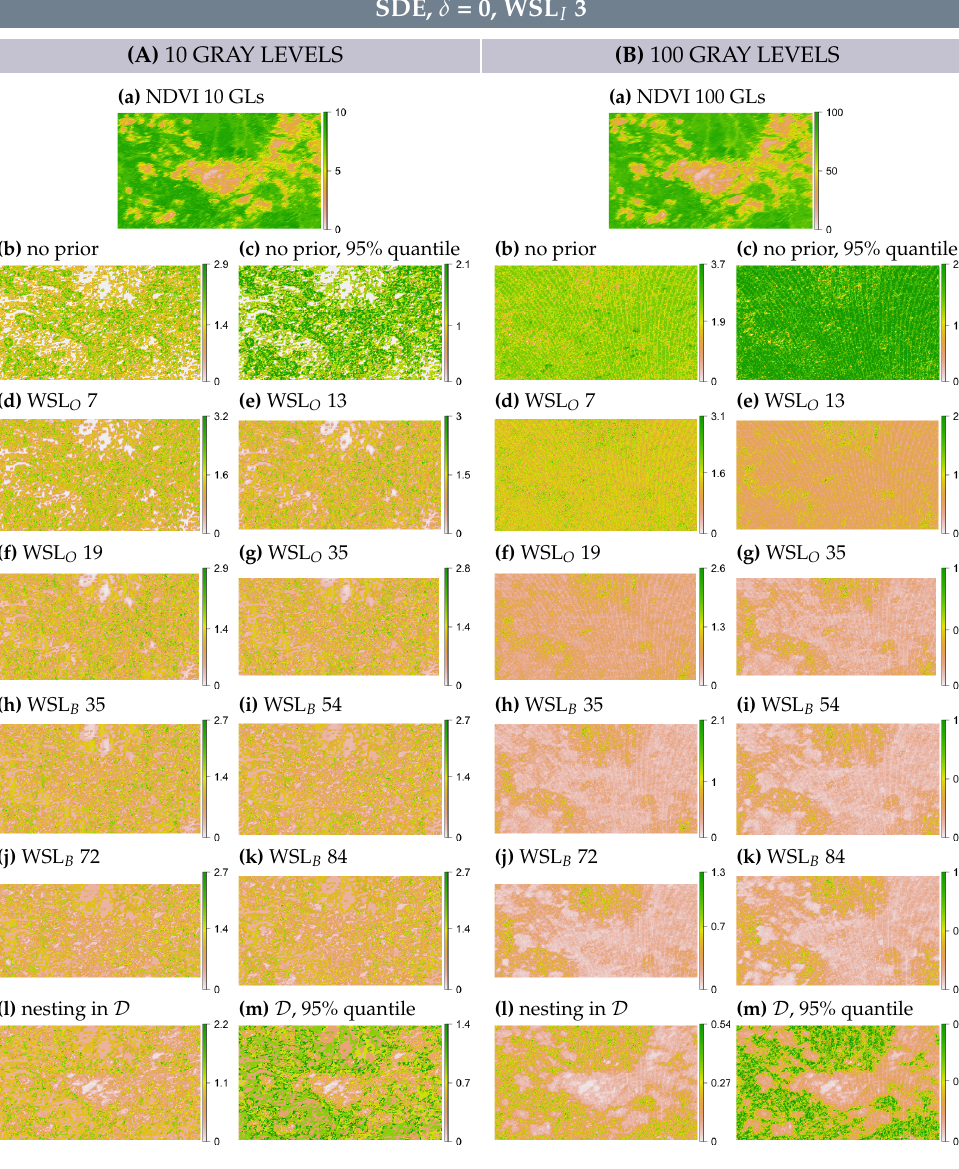
Figure 7. Structural diversity entropy (SDE), δ = 0, WSL I 3. Minimum values displayed are set to 0. (A,B) (c) No nesting, 95% quantiles, (A,B) (m) Nesting in D , 95%